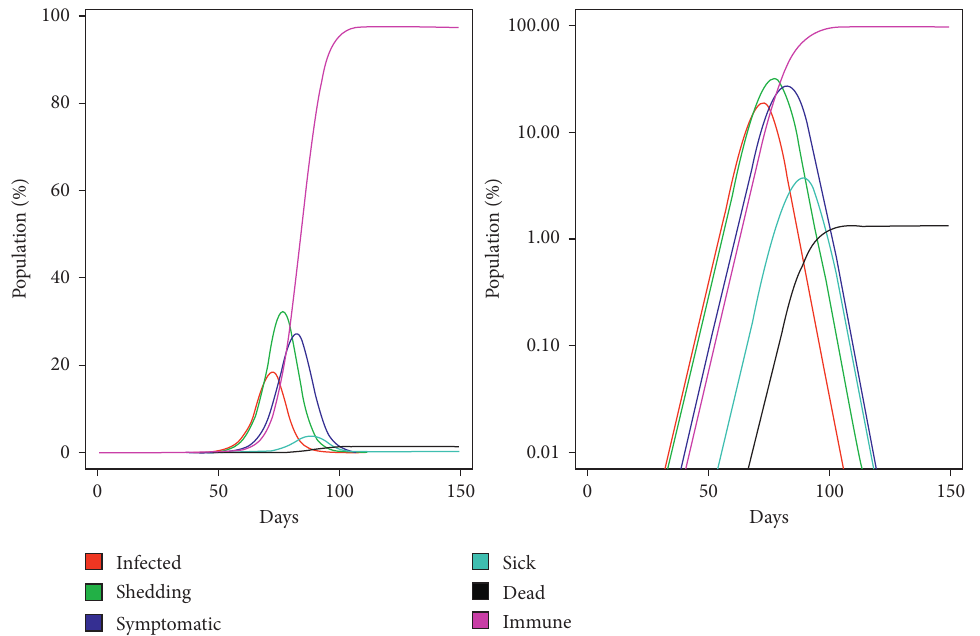
Figure 4: Model simulations with constant R